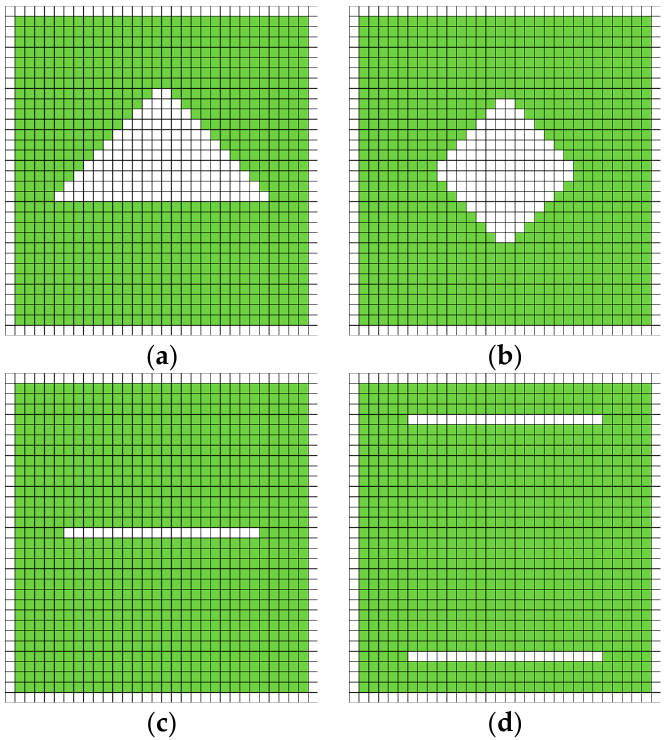
Figure 5. Testing the geometries of normalized multi-band patches: ( a ) triangle-slot patch, ( b ) circular slot patch, ( c ) single notch patch, and ( d ) double notch patch. Pixel dimensions: 5 mm × 5 mm. Green: conductive surface; white: uncovered substrate.